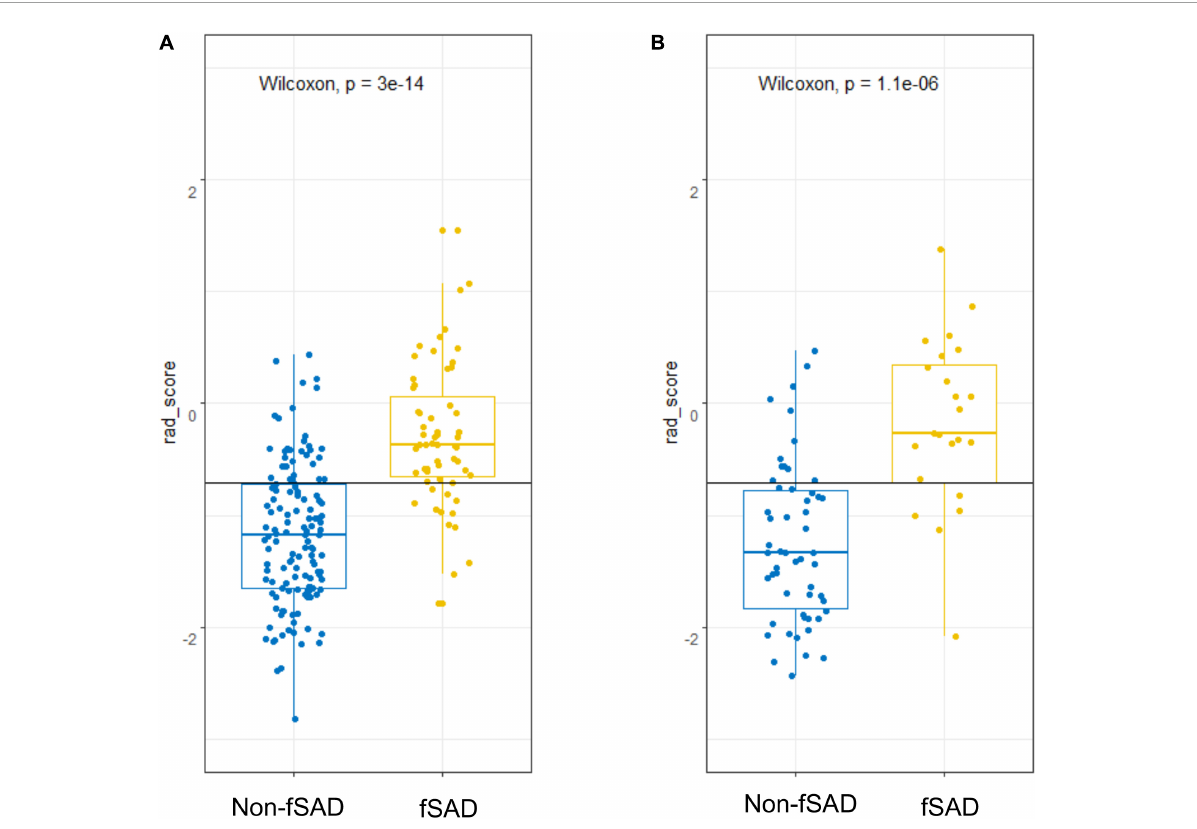
FIGURE4 fSAD risk prediction using rad-score. Score dot diagrams showing the rad-score in (A) the training cohort and (B) the validation cohort. High fSAD risk is shown in yellow risk of fSAD, and low risk of fSAD is shown in blue. A high change of fSAD is indicated by a higher score. fSAD, small airway dysfunction; Rad-score, radiomic score.